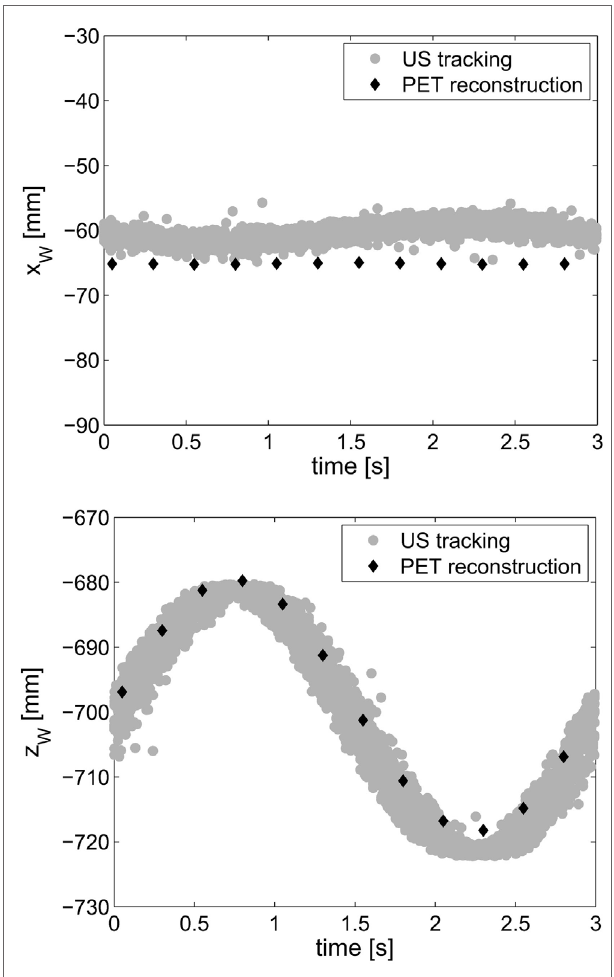
FigUre 7 | Ultrasound tracking data transformed to world coordinates (gray dots) and PeT reconstruction data along the x W - and z W -axes . The PET data have been corrected for the constant offsets both between rubber ball and radioactive point source as well as between the PET coordinates and the world